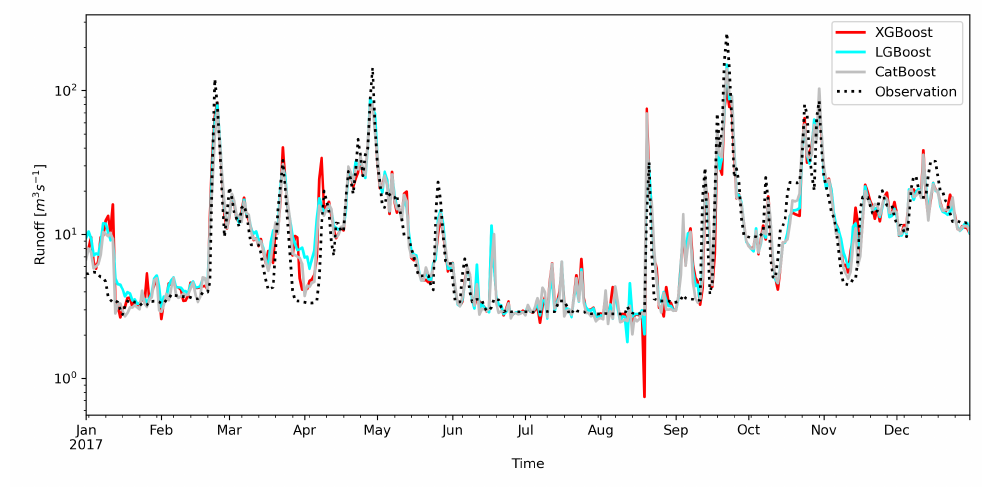
Figure 9. Daily runoff forecast for Wadowice on Skawa River in year 2017—high flows case. The models usually behave similarly, but there is a difference in the XGBoost forecasts (Figure 10). The plot shows one of the largest flood waves from 2014. The XGBoost model significantly overestimated the flow forecast compared to the other models. You can also see serious problems of all models with the projection of the forecast after the culmination of the wave has passed.